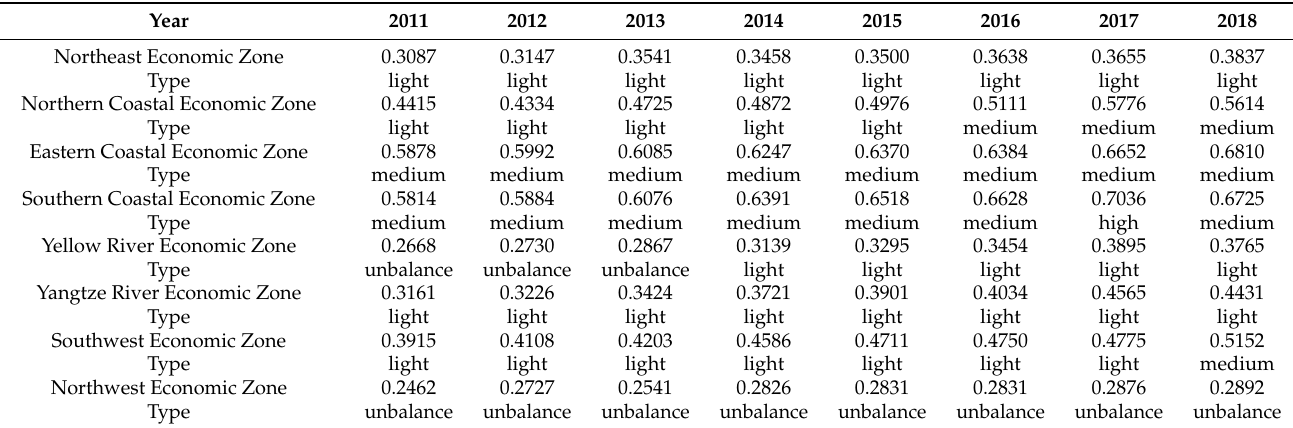
Table 4. Status and types of coupling and coordination between digital economy and carbon emissions reduction in eight regions.